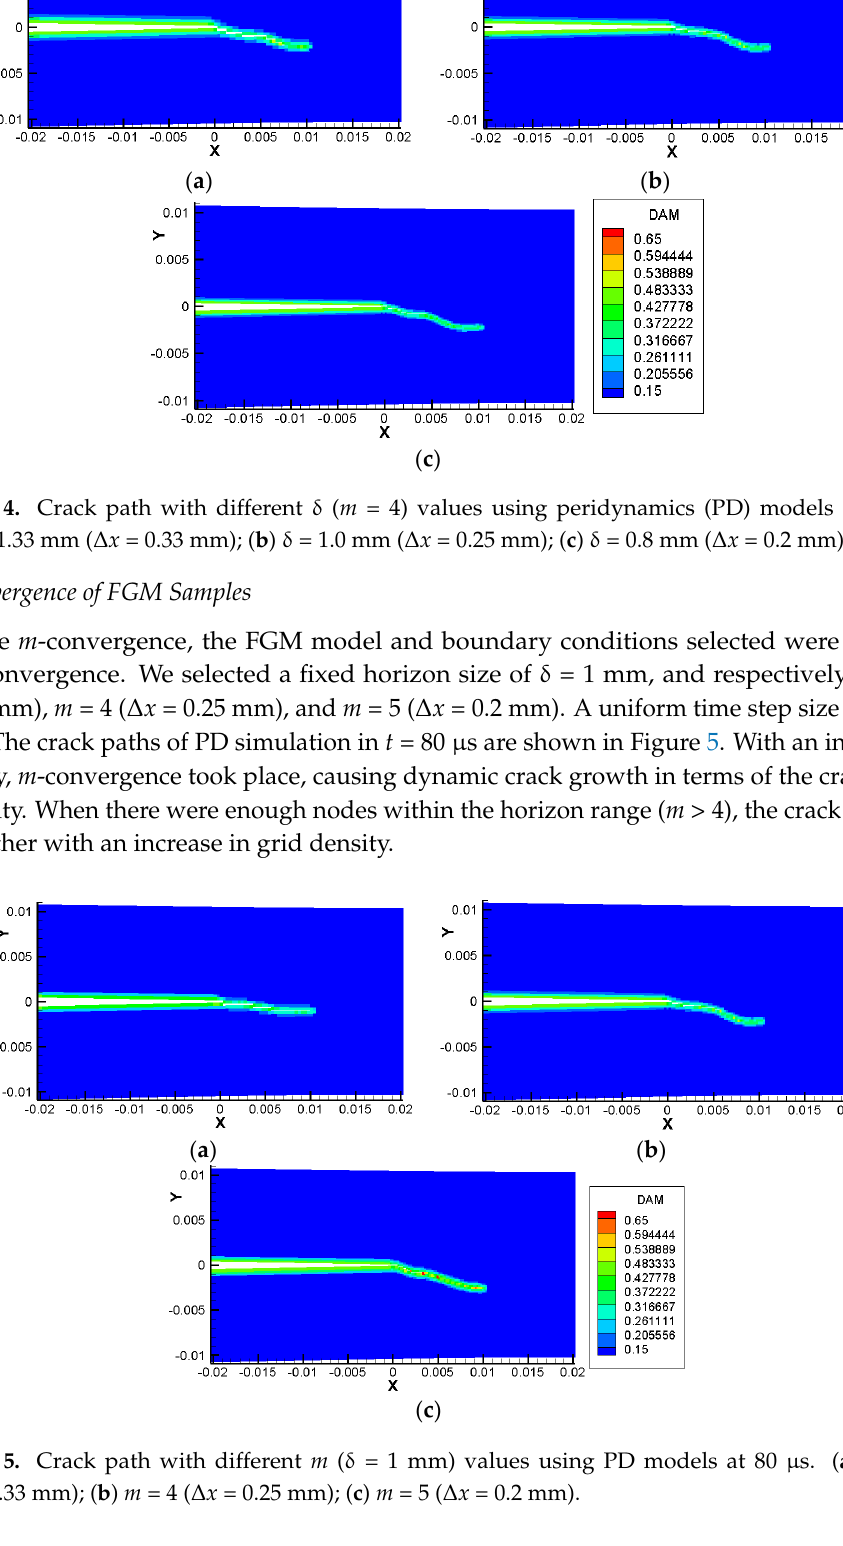
( b ) m = 4 (Δ x = 0.25 mm); ( c ) m = 5 (Δ x = 0.2 mm) ( ∆ x = 0.33 mm); ( b ) m = 4 ( ∆ x = 0.25 mm); ( c ) m = 5 ( ∆ x = 0.2